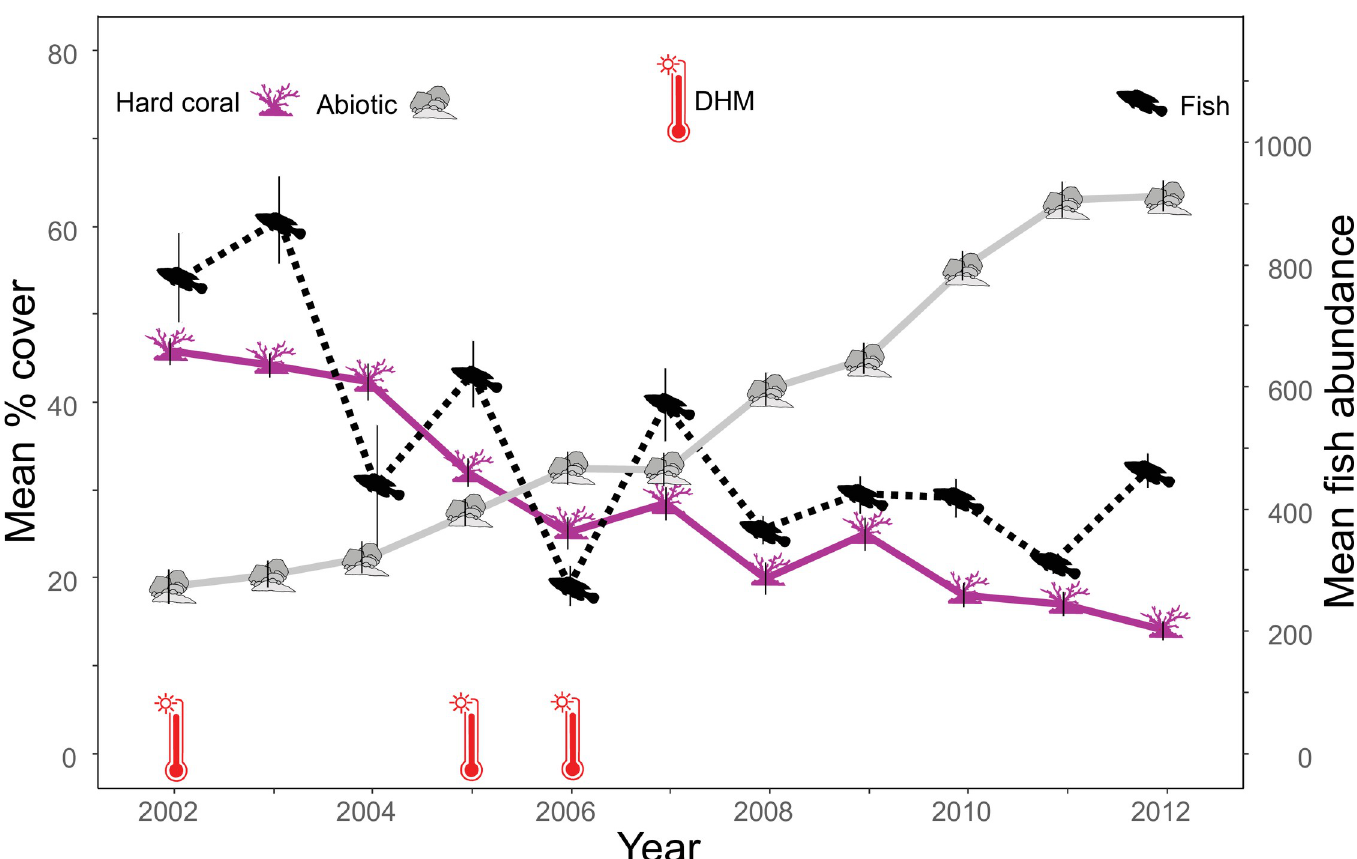
Fig 2. Yearly changes per transect in mean fish community abundance and mean cover of hard coral and abiotic benthos (vertical lines represent standard error). Occurrence of one Degree Heating Month (DHM) displayed for each corresponding